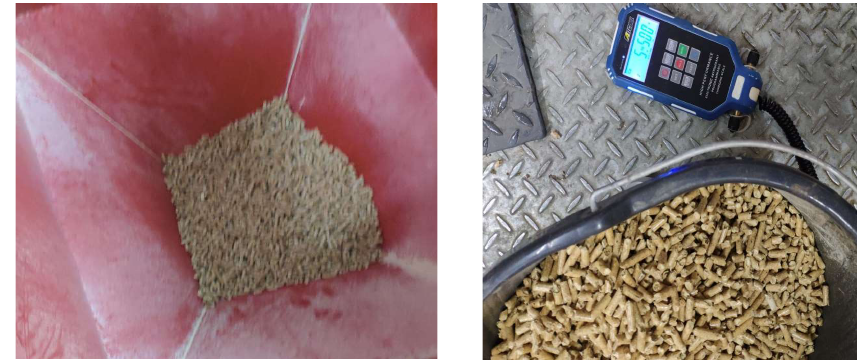
Energies 2023 , 16 , x FOR PEER REVIEW